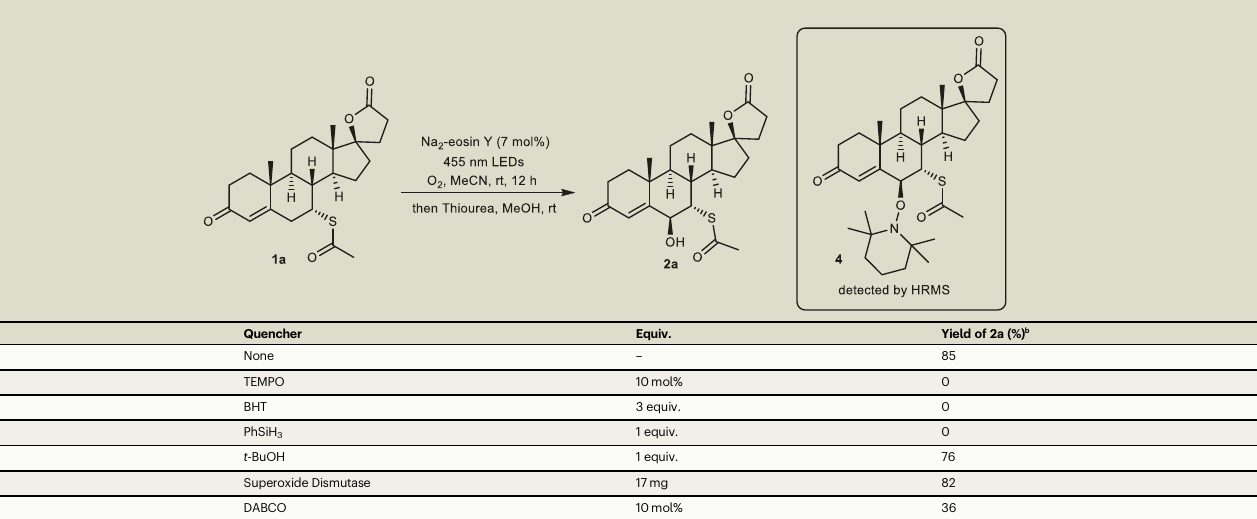
Table 2 | Quenching experiments for the hydroxylation of spironolactone (1a) a